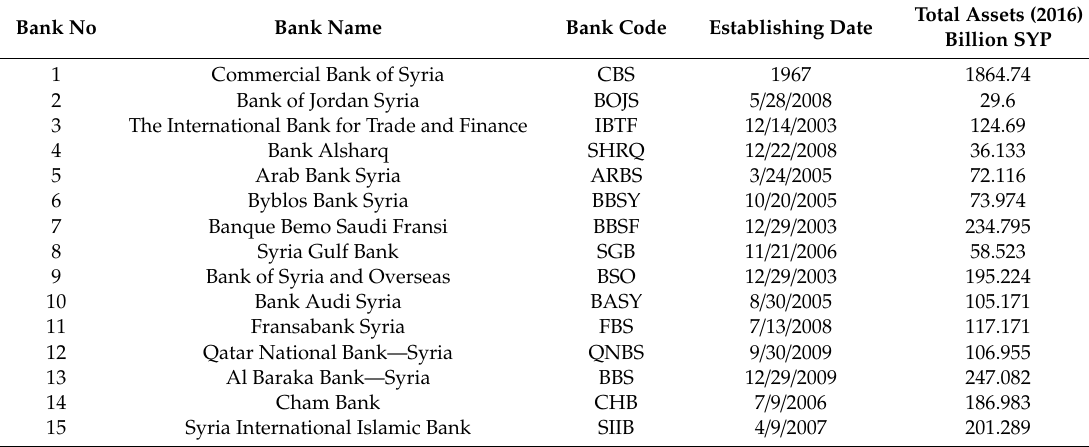
Table 1. List of all commercial Banks operating in